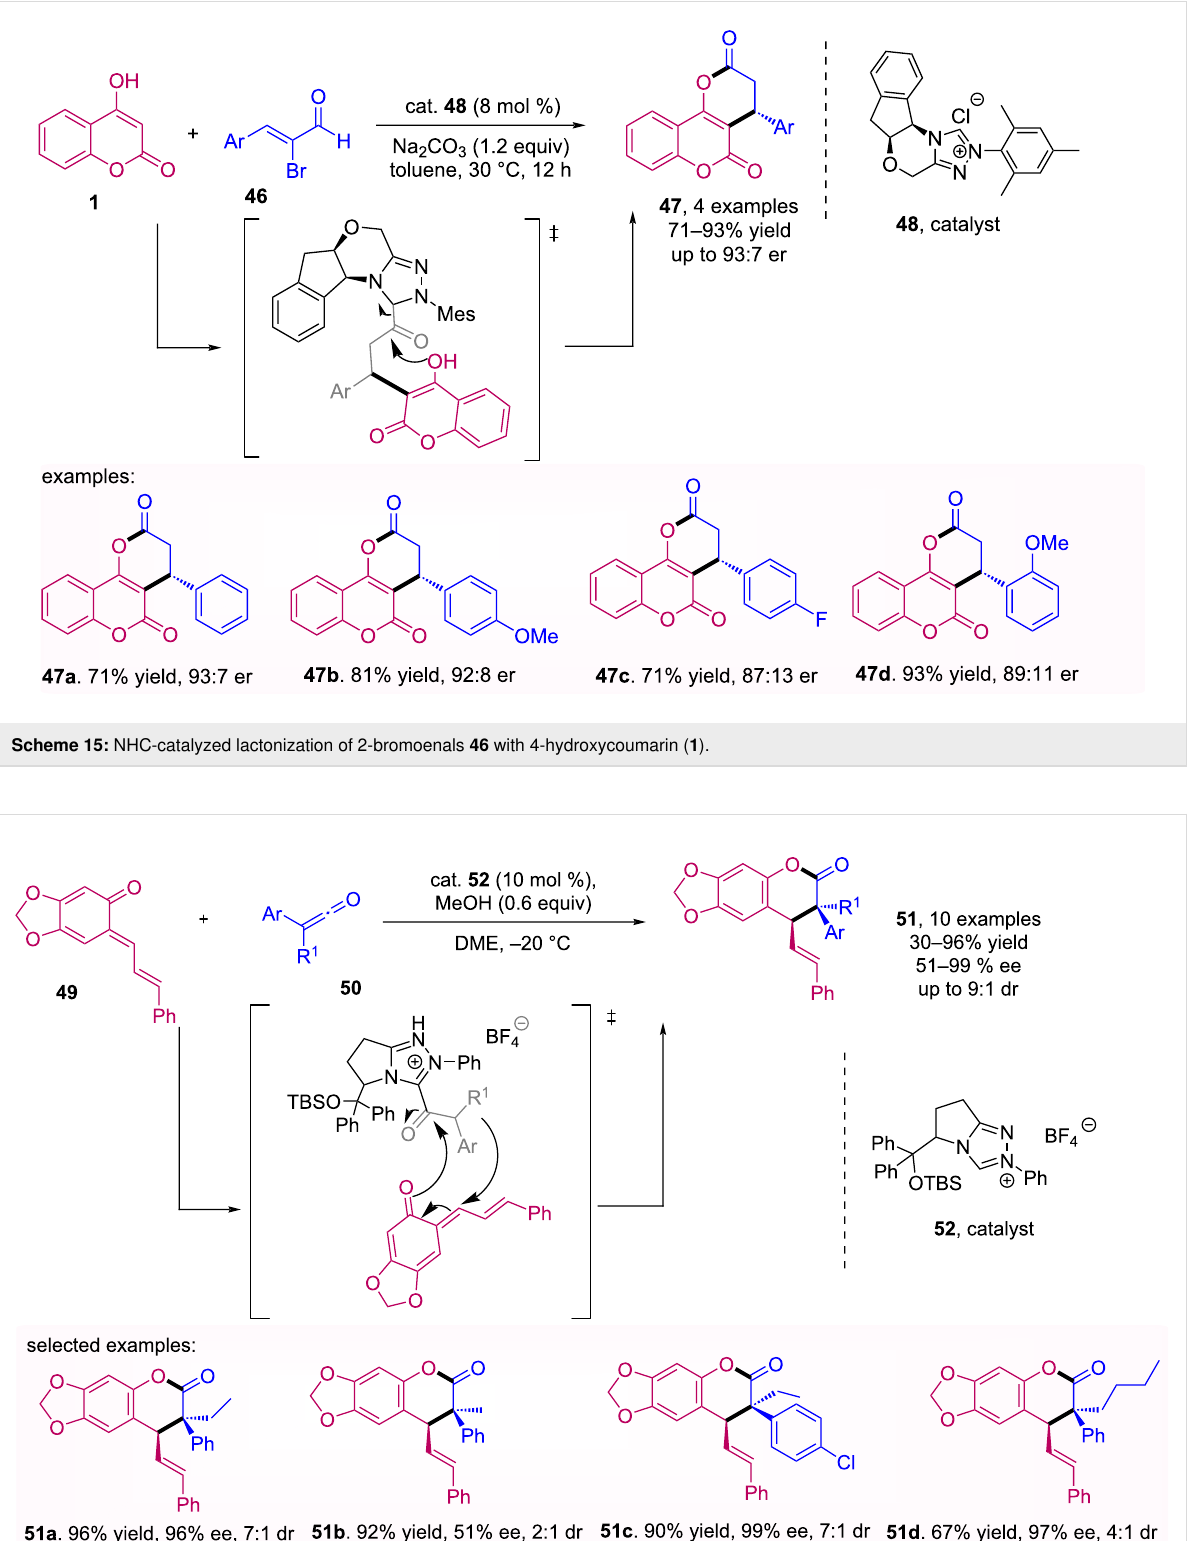
Scheme 16: NHC-catalyzed enantioselective synthesis of dihydrocoumarins 51